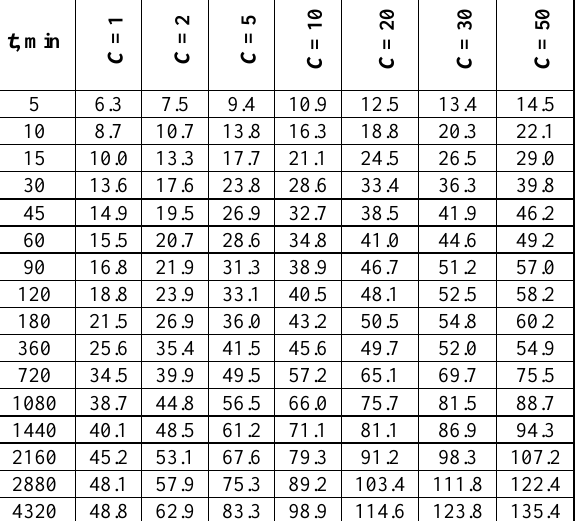
Table 4. Theoretical rainfall amounts determined on the basis of measurement data from